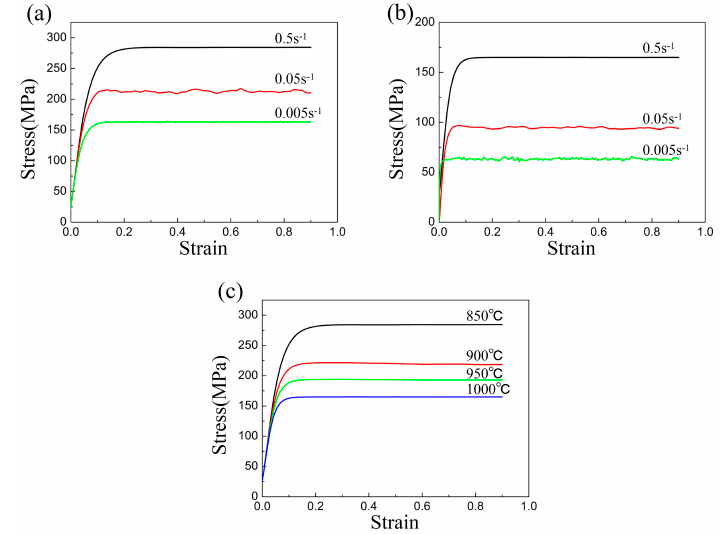
Figure 9. Compression stress - strain curves of FeMnSiCrNi SMA at the various temperatures and strain rates based on CA simulation: ( a ) 850 T  °C; (b) 1000 T  °C; (c) ε 0.5   s − 1 . rates based on CA simulation: ( a ) T = 850 ◦ C; ( b ) T = 1000 ◦ C; ( c ) . ε = 0.5 s − 1